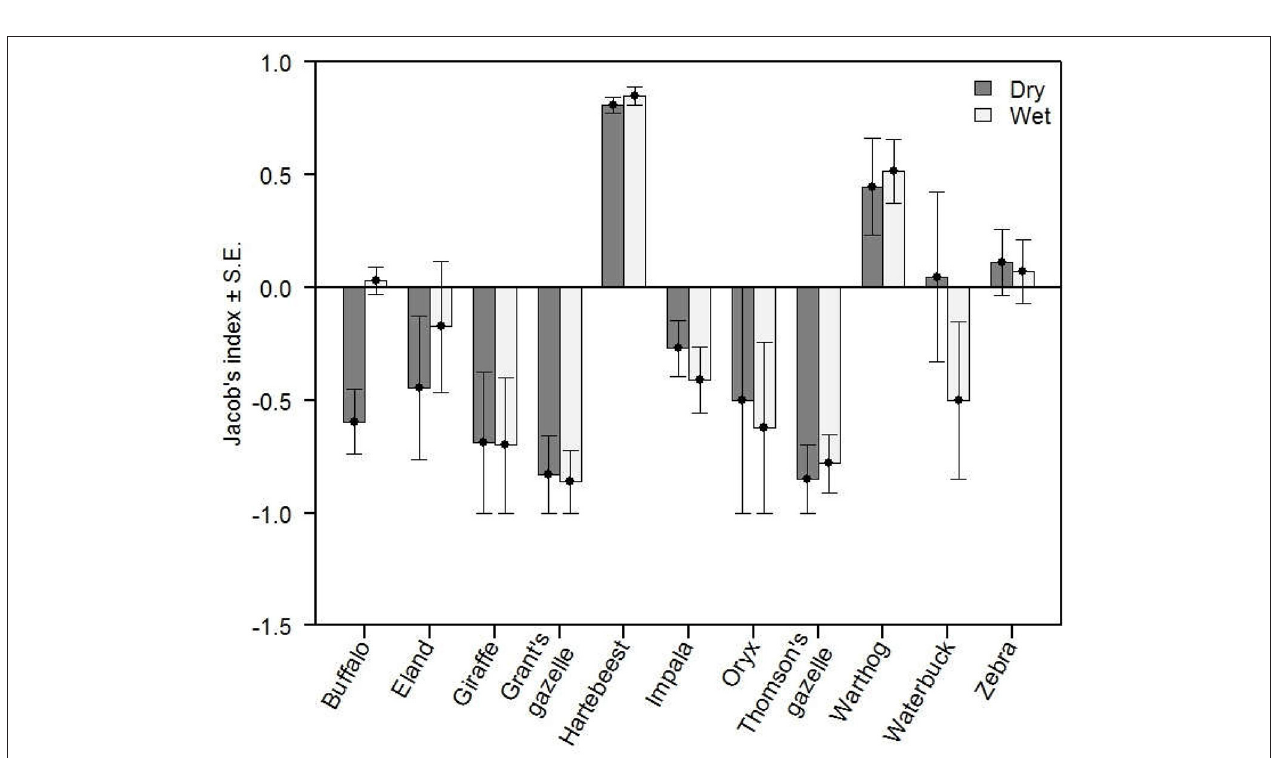
FIGURE 3 | Selectivity indices (Jacobs’ index of selection) for 11 species of ungulates by five lion prides during wet and dry seasons. Hartebeest (and warthog, to a lesser extent) are selected regardless of season, while zebra are killed in proportion to their abundance in both seasons. All other species of ungulates are avoided during at least one season. Error bars represent standard